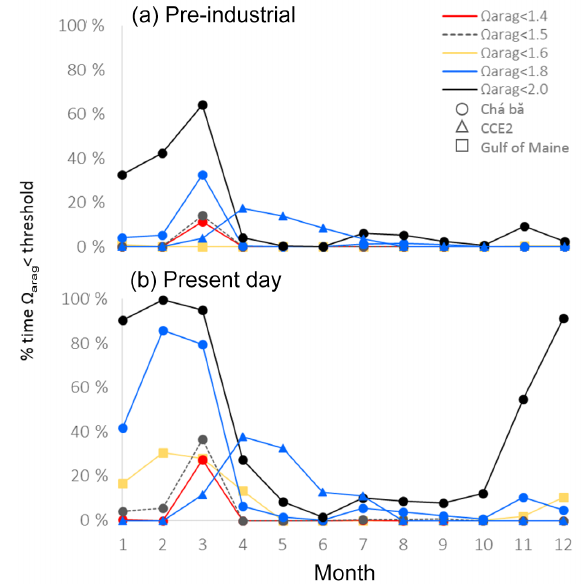
Figure 9. Percent time that (a) preindustrial and (b) present-day surface seawater (cid:127) arag conditions fall below biological thresholds: chronic exposure for Ostrea lurida larvae at (cid:127) arag <1.4 in red, acute effect of Crassostrea gigas larvae at (cid:127) arag <1.5 in gray, chronic ex- posure for Mya arenaria larvae at (cid:127) arag <1.6 in gold, chronic ex- posure for Mytilus californianus larvae at (cid:127) arag <1.8 in blue, and chronic exposure for C. gigas larvae at (cid:127) arag <2.0 in black. Thresh- olds at the Chá b˘a mooring are shown as circles; thresholds at the CCE2 mooring (only for M. californianus larvae) are shown as tri- angles; thresholds at the Gulf of Maine mooring (only for M. are- naria larvae) are shown as squares. The one acute threshold is indi- cated by a dashed